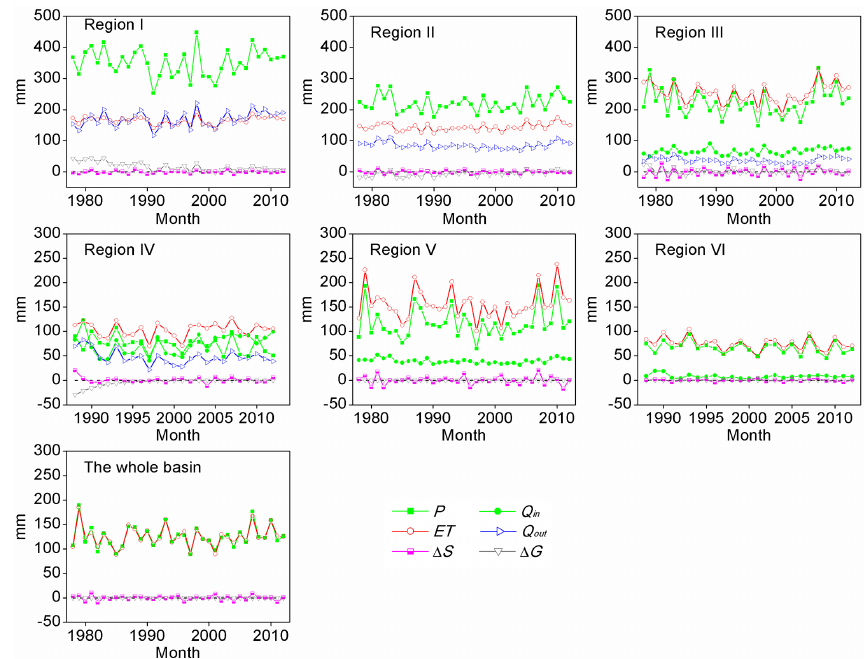
Figure 6. Variation of annual water balance for all the regions simulated using the abcd